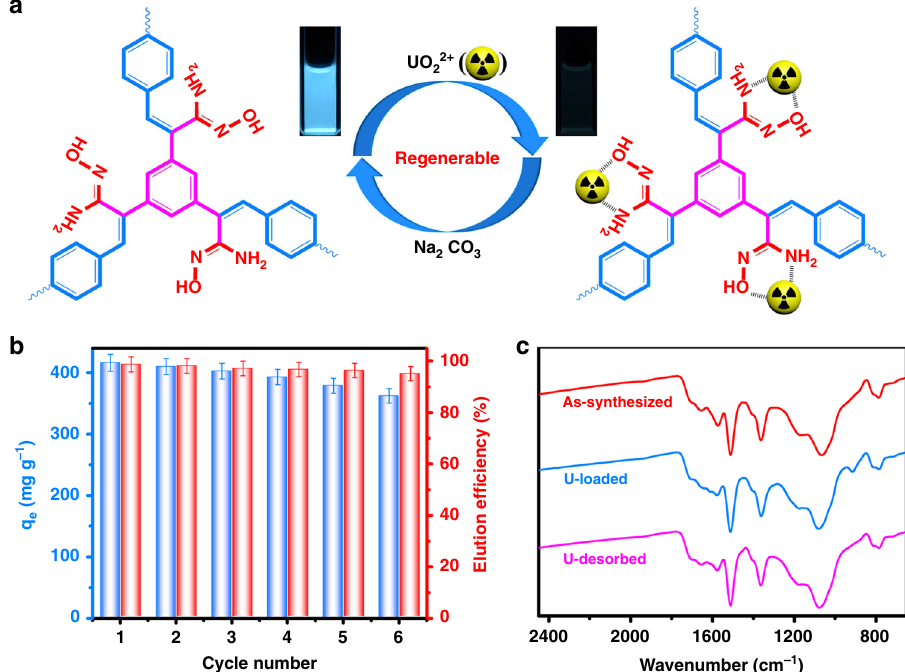
Fig. 7 UO 2 2 + adsorption and regeneration investigations. a Schematic diagram of TFPT-BTAN-AO regeneration detection and extraction of UO 2 2 + . b The UO 2 2 + adsorption capacity (left axis) and elution ef fi ciency (right axis) of TFPT-BTAN-AO in six successive adsorption – desorption cycles. c FT-IR spectra of TFPT-BTAN-AO, TFPT-BTAN-AO after extraction of UO 2 2 + , and TFPT-BTAN-AO after desorption of UO 2 2 + by the Na 2 CO 3 (1.0 mol L − 1 ) aqueous solution. Error bars represent S.D. n = 3 independent